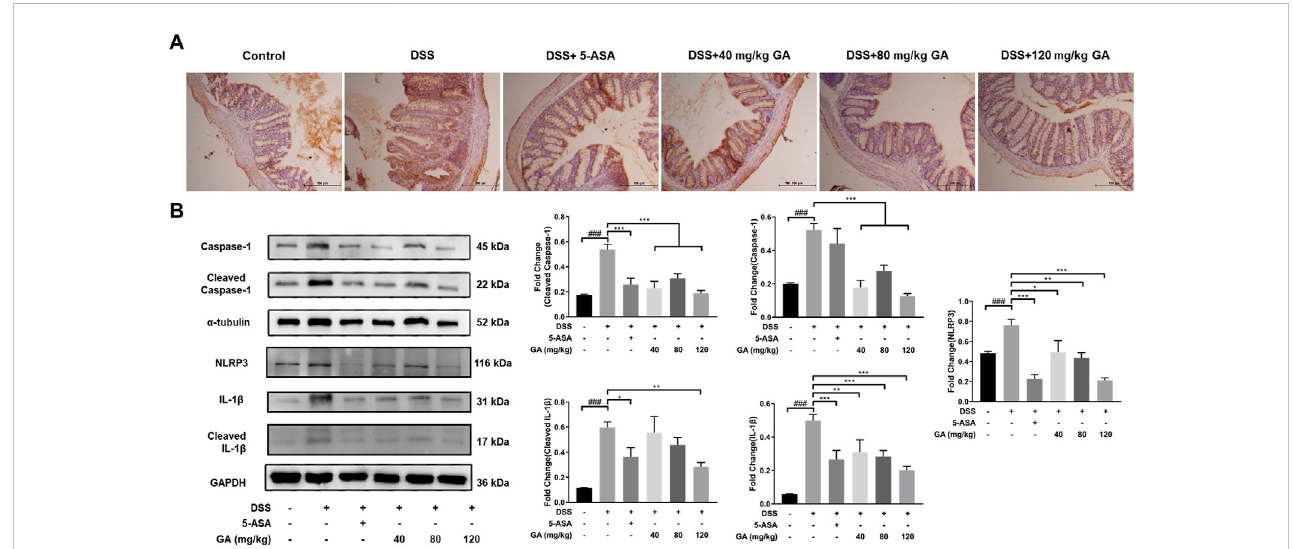
FIGURE 4 GA suppressed NLRP3 expression to inhibit in fl ammasome activation. (A) Immunohistochemistry results (100×) of NLRP3 staining in the colon tissue of mice with DSS-induced colitis. (B) Total protein was extracted from the colon tissue of different groups of mice. Protein expressions of Caspase-1, cleaved Caspase-1, NLRP3, IL-1 β , and cleaved IL-1 β in the colon tissue were measured using western blotting. Data are presented as mean ± SD (n = 3). ## p < 0.01, ### p < 0.001 vs. Control group by t -test; * p < 0.05, ** p < 0.01, and *** p < 0.001 vs. DSS